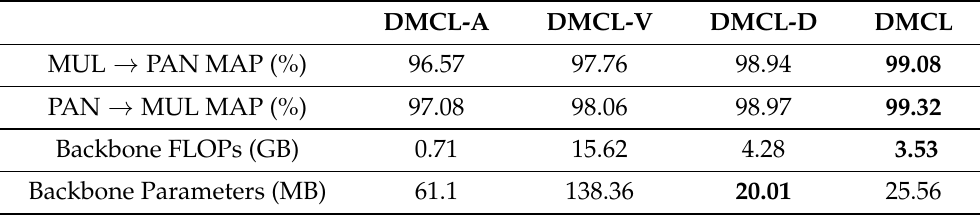
Table 1. Retrieval results of different DCMLs with different backbones. MUL → PAN means the query is MSP images, and the target samples are PAN images. PAN → MUL indicates the query is PAN images, and the target samples are MSP